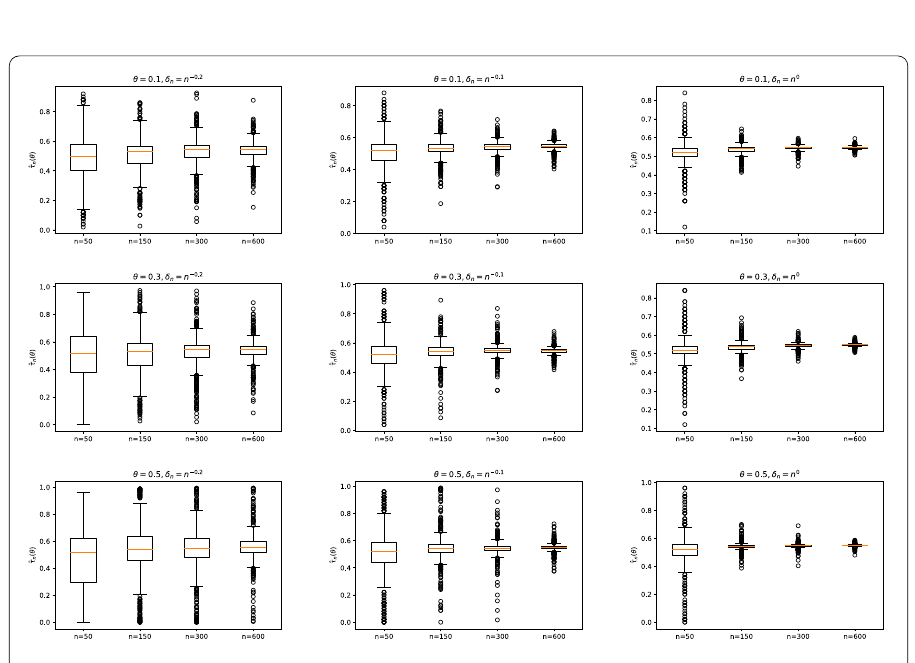
Figure 2 Boxplots of ˆ τ n ( θ ) with different values of parameters θ and δ n in the case τ 0 =